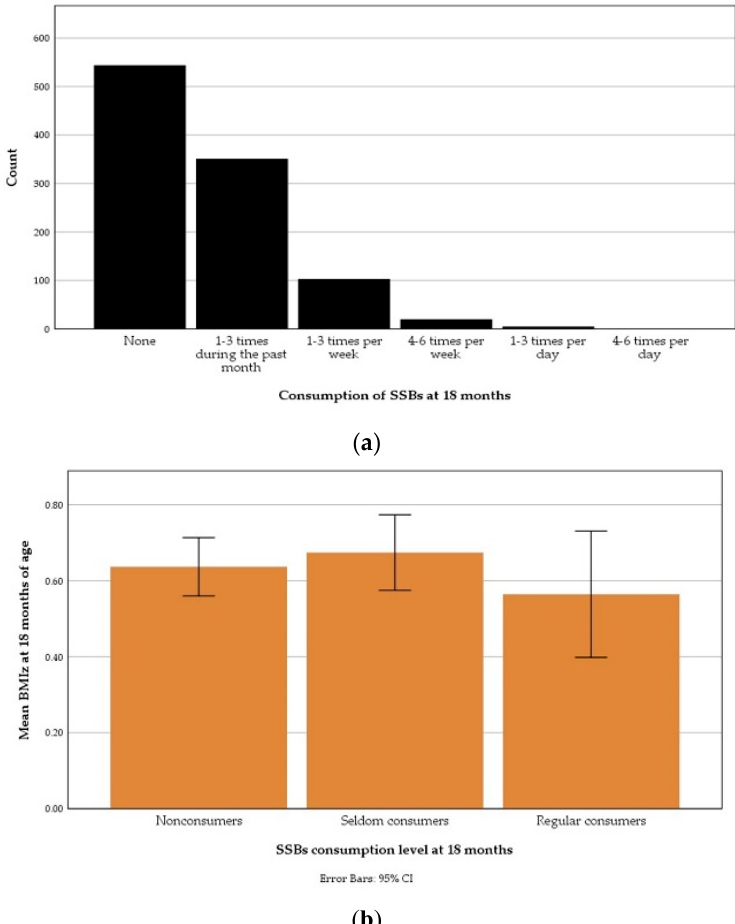
Figure 4. Sugar-sweetened beverage consumption during the past month at 18 months of age: ( a ) According to one-month-recall food frequency questionnaire responses; ( b ) An error bar graph displaying mean body-mass index z -score (BMIz) at 18 months according to consumption level.